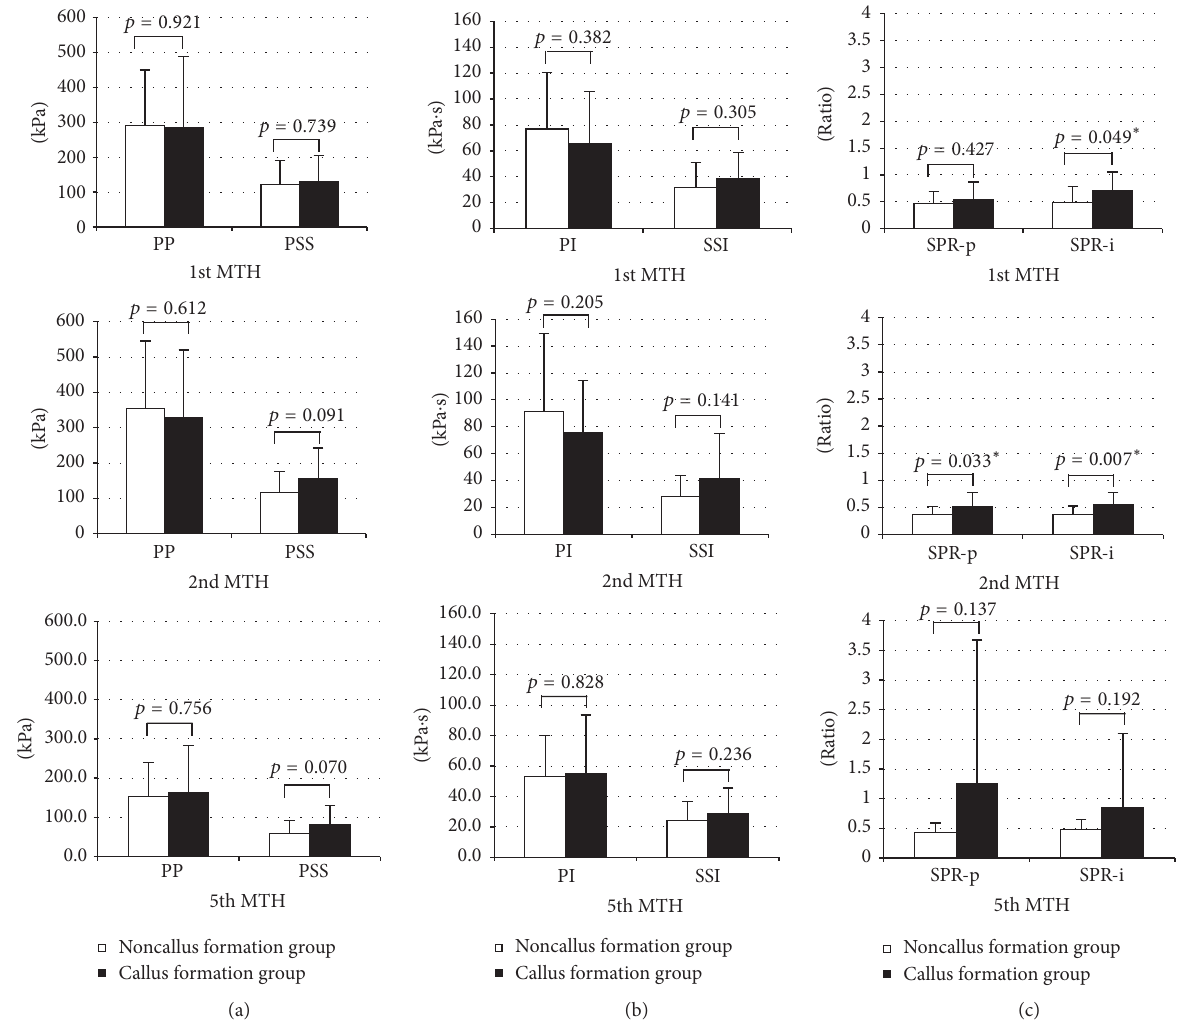
Figure 3: MTH: metatarsal head. (a) Peak normal stress (pressure) (PP) and peak shear stress (PSS), (b) normal stress (pressure) time integral (PI) and shear stress time integral (SSI), and (c) shear stress/normal stress (pressure) ratio of peak value (SPR-p) and shear stress/normal stress (pressure) ratio of time integral value